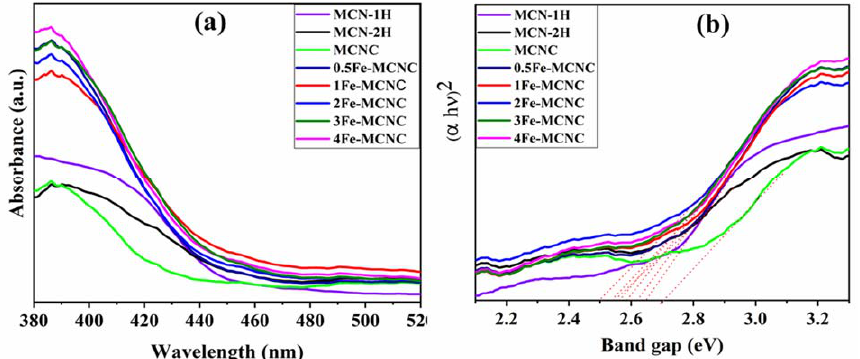
Figure 2. ( a ) UV ‐ Vis DRS spectra and ( b ) Tauc plot of the MCN and Fe ‐ MCNC nanostructures. (Red dotted lines are the tangents, drawn here to represent the band gap values of the samples). The XRD patterns of MCN ‐ 1H, MCN ‐ 2H, and Fe ‐ MCNC are shown in Figure 3. MCN ‐ 1H and MCN ‐ 2H had two unique diffraction peaks at around 13.07°and 27.54°, in ‐ dicating that they shared the same crystal ‐ structure matches (JCPDS No. 87 ‐ 1526). The (002) and (100) crystal planes of g ‐ C 3 N 4 were responsible for these two peaks, which are associated with the inter ‐ planar stacking peak of the heptazine units and the in ‐ plane structural packing pattern of the tris ‐ triazine units, respectively [33]. However, MCN ‐ 2H had weaker peaks than MCN ‐ 1H. This reveals the efficient exfoliation of the MCN ‐ 2H sample [34]. Compared to the XRD pattern of MCN ‐ 1H and MCN ‐ 2H, the (100) peak of MCNC was barely discernible, indicating that MCNC had a reduced planar dimension [35]. In the meantime, the intensity of the (002) peak decreased; the overall strength of the diffraction peaks of Fe ‐ MCNC became weaker as the Fe content increased in the XRD pat ‐ terns. It was revealed that Fe and MCNC showed host–guest interactions, in which a small amount of Fe species might inhibit MCNC condensation [19]. Interestingly, when the Fe content increased, the intensity of the (002) peak reduced significantly, indicating that too